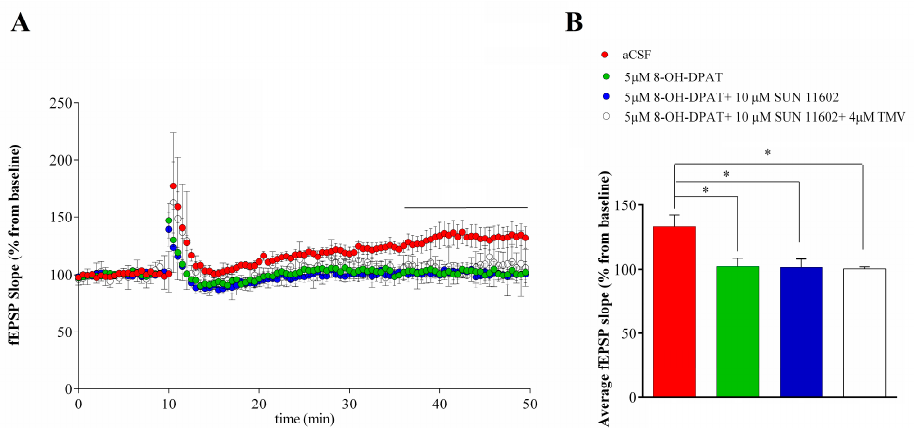
Figure 6. ( A ) A field Excitatory PostSynaptic Potential (fEPSP) slope (10% and 80% of max) recorded before and after the Schaffer Collateral high-frequency stimulation in FSL rats. Values were normalized to the mean value obtained over the last 20 min of the baseline period and expressed as a percentage of this baseline value (n = 6 slices for aCSF, n = 7 for 5 µM 8-OH-DPAT, n = 7 slices for 5 µM 8-OH-DPAT + 10 µM SUN 11602, n = 4 slices for 5 µM 8-OH-DPAT + 10 µM SUN 11602 + 4µM TMV). Two-way ANOVA test F (3, 21) = 4.2585, p < 0.05. Tukey’s multiple comparisons test: aCSF vs. 5 µM 8-OH-DPAT, p < 0.05; aCSF vs. 8-OH-DPAT + 10 µM SUN 11602, p < 0.05; aCSF vs. 5 µM 8- OH-DPAT + 10 µM SUN 11602 + 4 µM TMV, p < 0.05 from 30 to 40 min (black line) of recording post